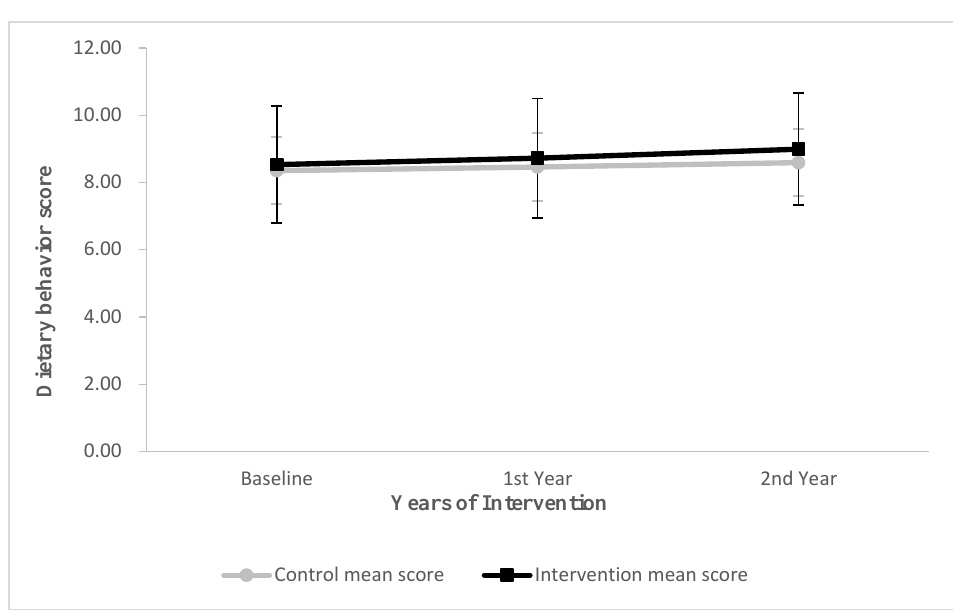
Figure 4. Changes in mean score for children’s dietary behaviors in first and second year from baseline. Vertical bars indicate standard deviations. Table 8. Test of the fixed effects of various factors of dietary behavior score.